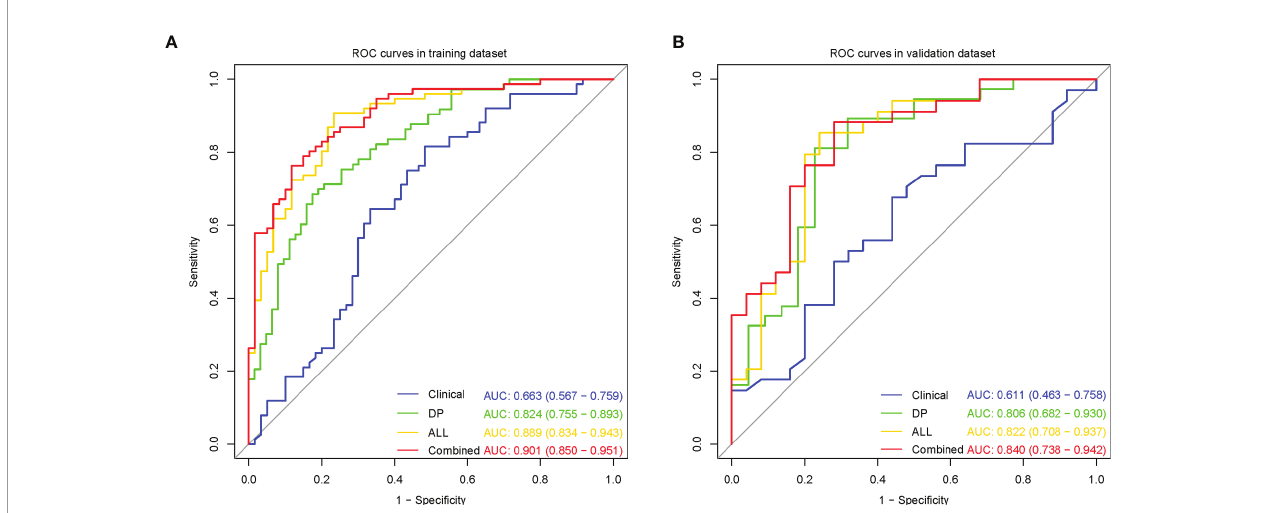
FIGURE 3 | Receiver operating characteristic (ROC) curves for microvascular invasion prediction of different models in the training (A) and validation (B) datasets. (Clinical, the clinical model based on effective clinical parameters; DP, the DP radiomics model based on features from delayed phase; ALL, the fusion radiomics model based on features from all sequences; Combined, the combined model based on radiomics features from all sequences and effective clinical parameters).